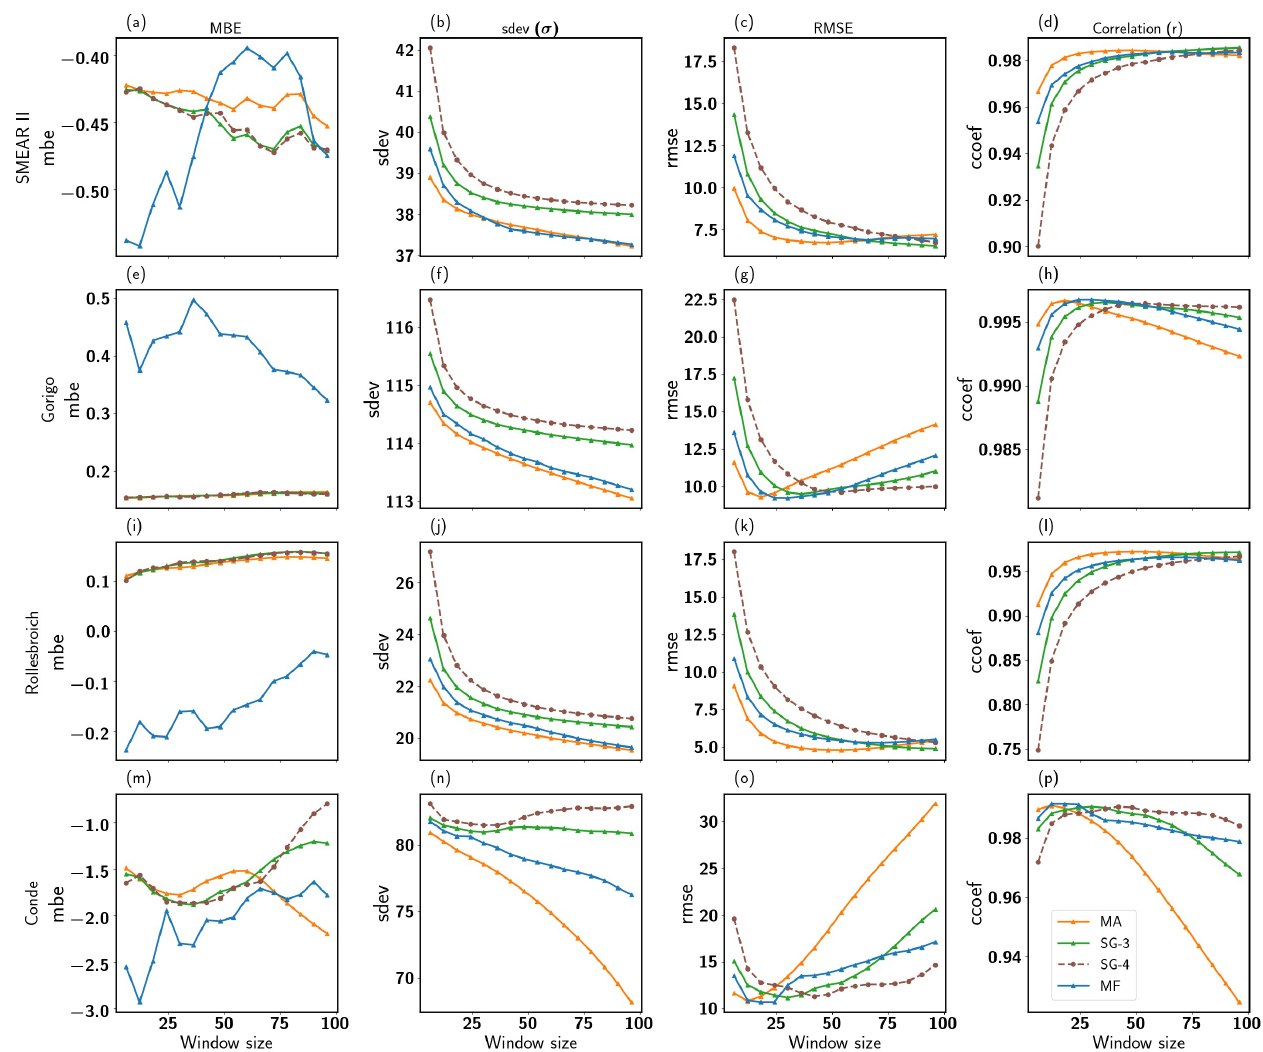
Figure 5. Performance of MA (red), MF (blue) and SG filters as a function of window length. The MBE, standard deviation, RMSE and correlation are presented in columns for SMEAR II ( a – d ), Gorigo ( e – h ), Rollesbroich ( i – l ) and Conde ( m – p ) for the four stations (in rows),